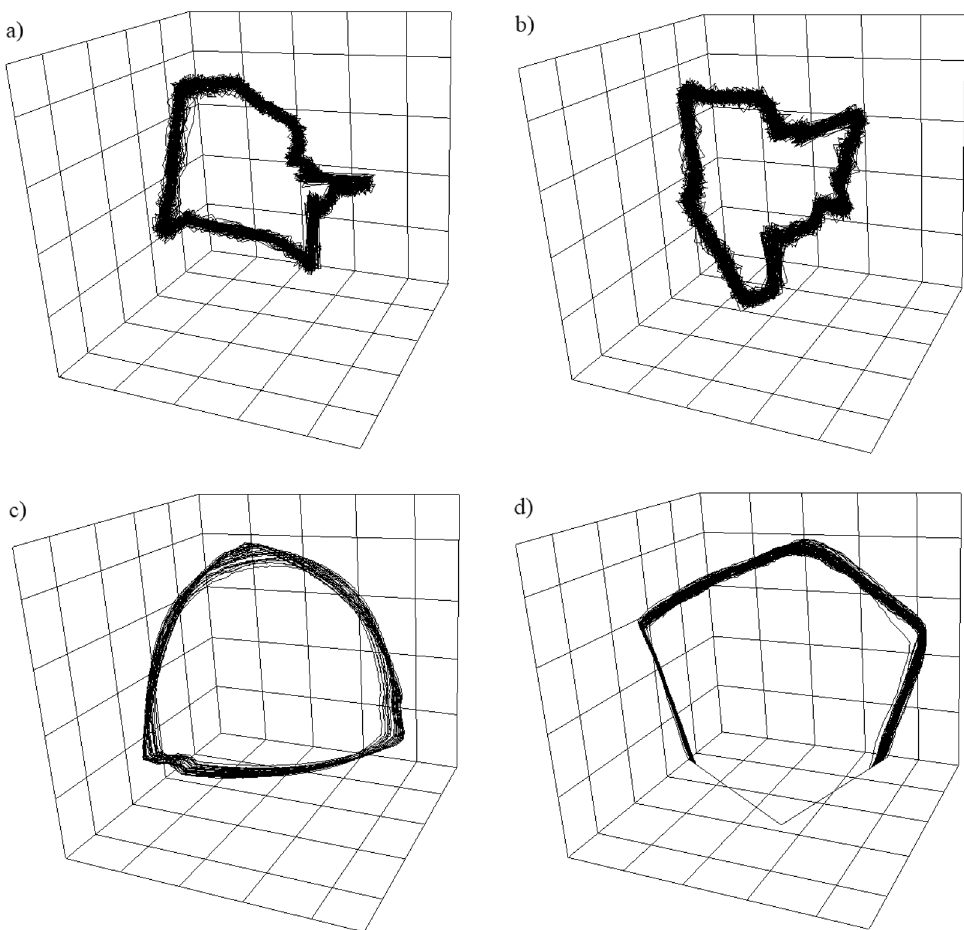
Figure 10. 3D attractor reconstructions for water and c–c aqueous solutions at an air flow rate of q = 0.026 l/ min. ( a ) Attractor reconstruction from the pressure fluctuation time series for water, ( b ) attractor reconstruction from the pressure fluctuation time series for c–c aqueous solutions, ( c ) attractor reconstruction from the time series representing the liquid penetration into the capillary for water, ( d ) attractor reconstruction from the time series representing the liquid penetration into the capillary for c–c aqueous solutions.